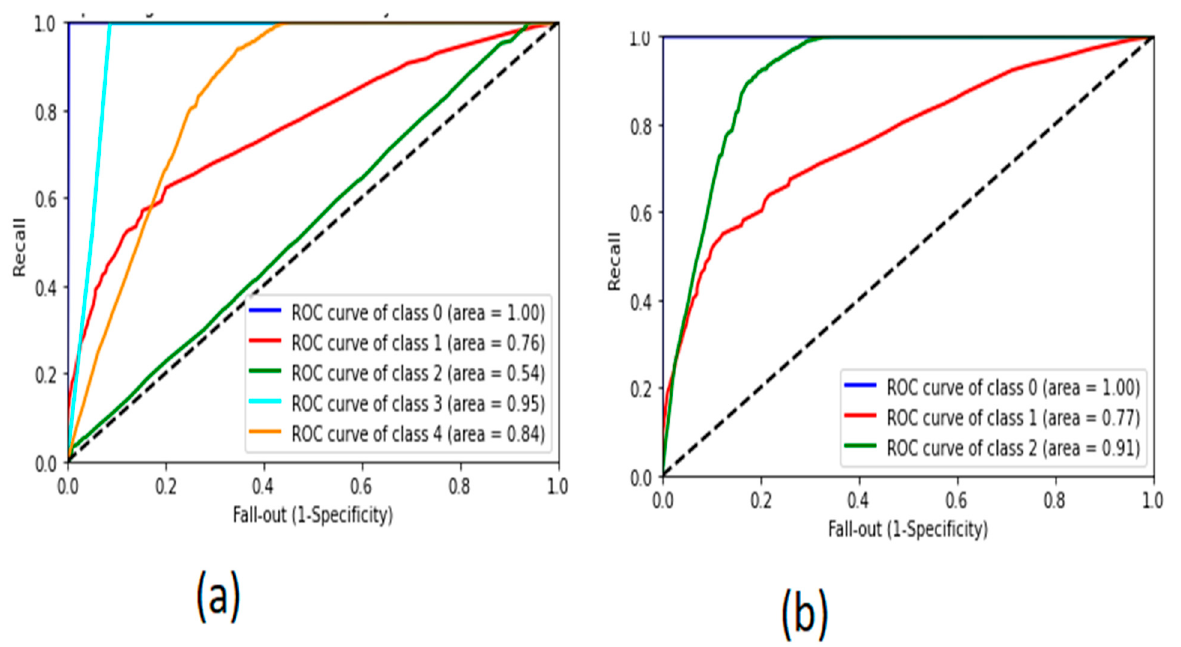
Figure 14. The receiver operating characteristics curve of CNN–LSTM: ( a ) dataset with two classes and ( b ) dataset with three classes.